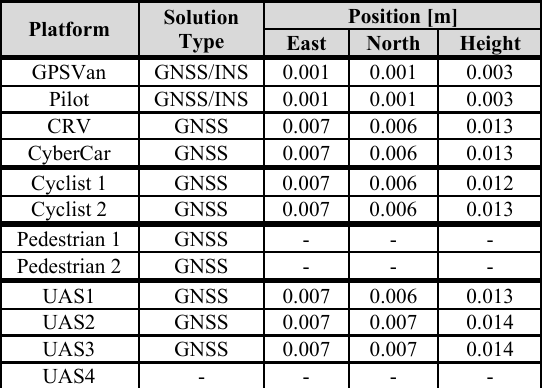
Table 1. Precision of post-processed GNSS/INS and GNSS